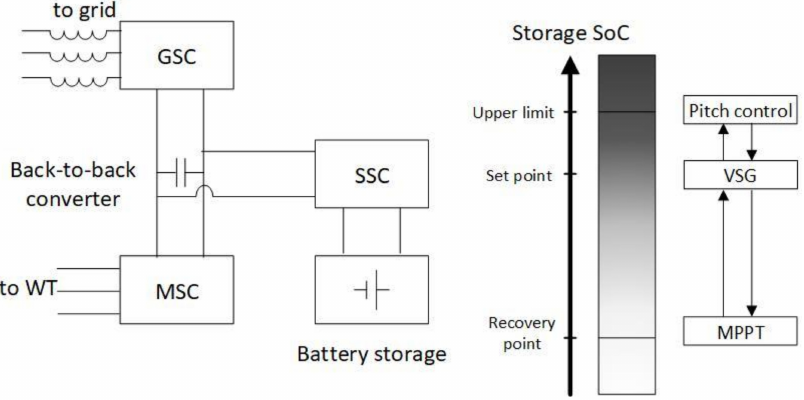
Figure 8. Fast storage as an additional apparatus for system